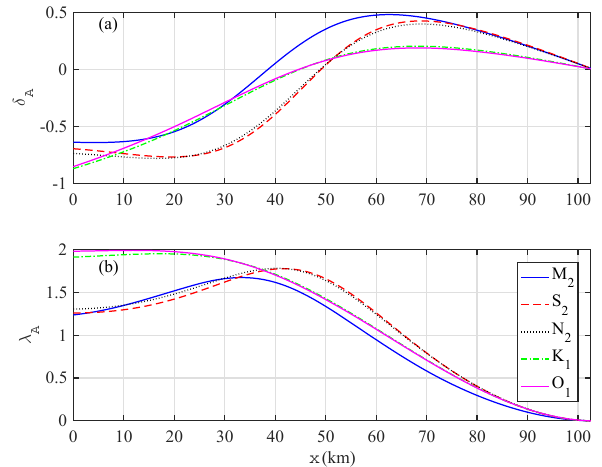
Figure 9. Longitudinal variations in tidal damping/amplification number δ A (a) and wave celerity number λ A (b) for different tidal constituents along the Guadalquivir